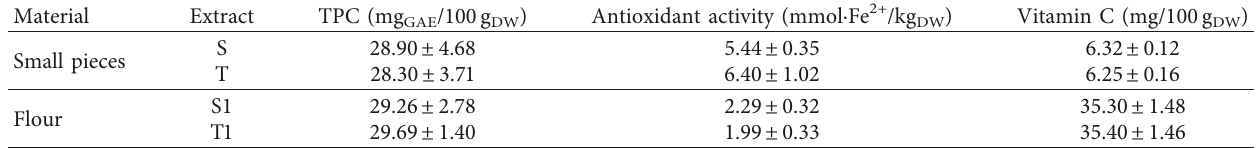
Table 1: Total polyphenol content, antioxidant activity, and vitamin C of the different breadfruit extracts. Material